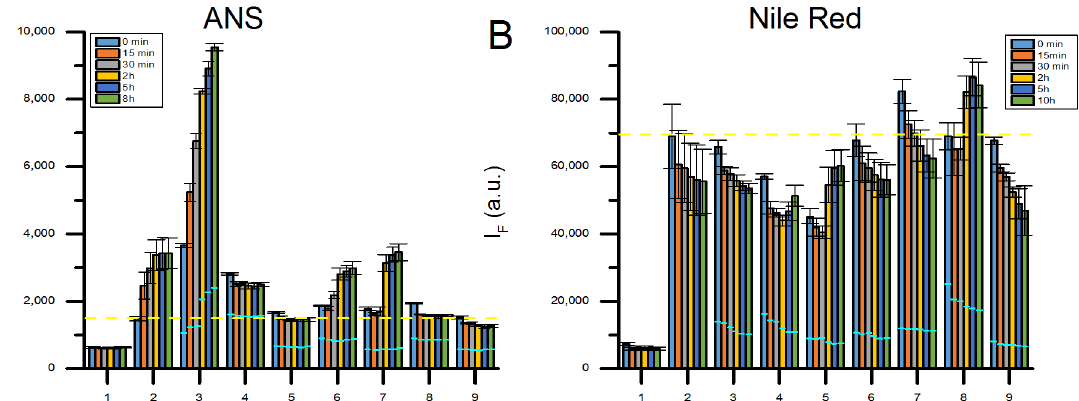
Fig 5. Screening results for 7 proteins and PS-NH 2 , ANS data in panel A and NR data in panel B, with corresponding controls. Bars represent the mean intensity value from three individual samples, with standard deviation in corresponding error bars, at 6 different time points; 0 min (blue), 15 min (red), 30 min (gray), 2 h (yellow), 5 h (dark blue) and 8 h (green) for the ANS data and 10 h (green) for the NR data. Fluorescence intensity of fluorophore with 1: Buffer only, 2: Particle only, 3: Lysozyme + particle, 4: HSA + particle, 5: OVA + particle, 6: CA-I + particle, 7: trCA-II + particle, 8: β -lactoglobulin + particle, 9: Calbindin + particle. Sky blue lines show the protein controls (i.e. protein with fluorophore) I F at each time point. In both panels a yellow dashed line is drawn across all samples representing the mean fluorescence from the particle control at time point 0 min.